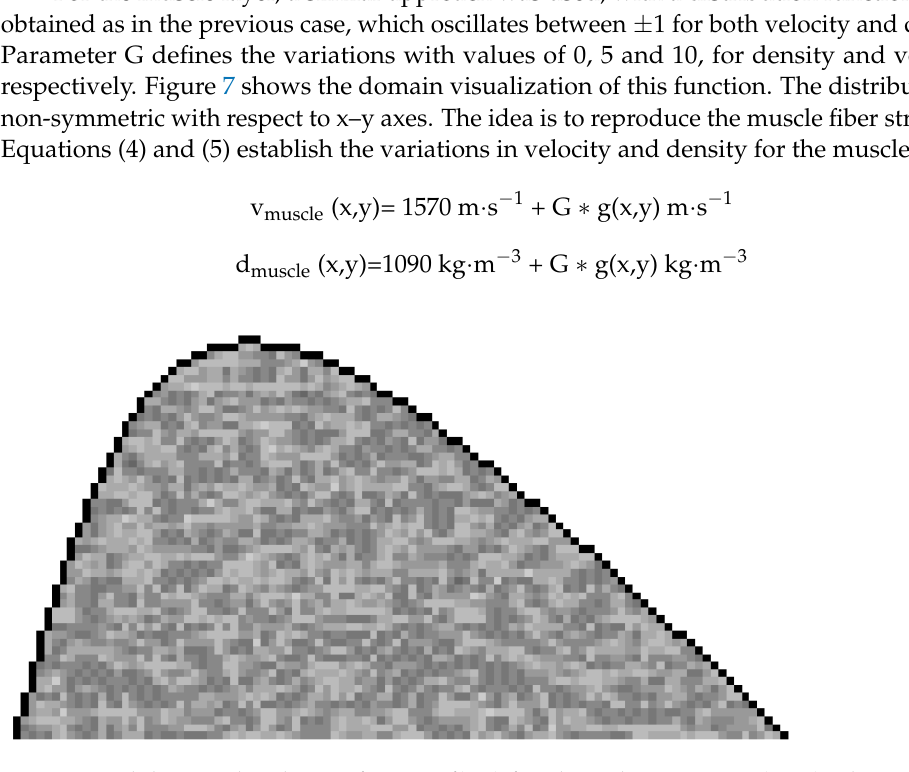
Figure 6. Subdomain distribution function f(x,y) for “lung disease zone” (LDZ). The grey scale in- dicates the spatial variation in the infiltrated properties of the lung tissue.